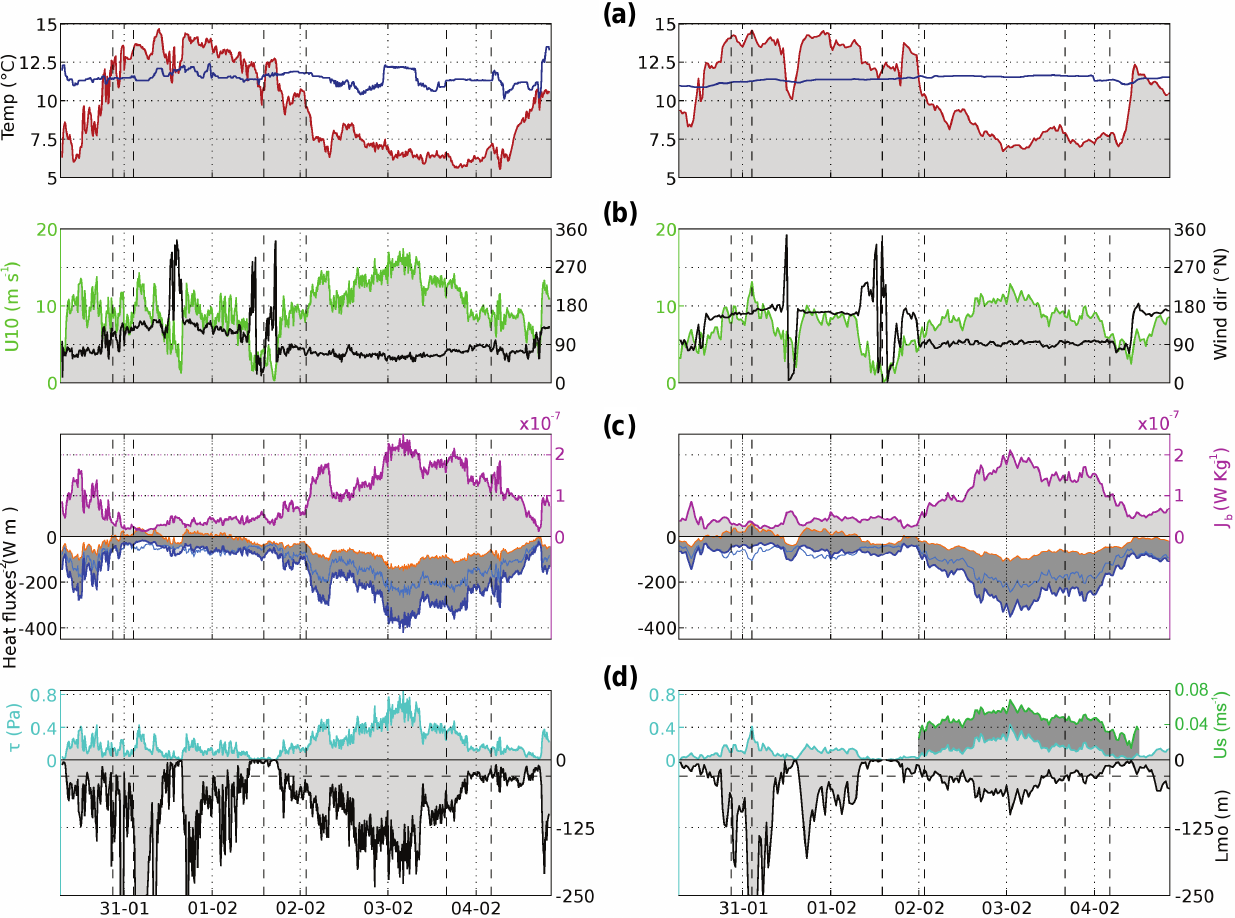
Figure 2. Atmospheric and sea-surface observations and fluxes collected from the R/V Urania (left panels) and VIDA buoy (right panels). (a) Air (red) and sea (blue) temperature time series; (b) wind speed (light green) and wind direction (black); (c) net (blue line), latent (light blue) and sensible (orange) heat fluxes computed with the COARE algorithm and buoyancy flux (magenta); (d) wind stress (cyano), Monin– Obukhov length (black) and Stokes drift (dark green). Given that the maximum depth of the GoT is 25m, L mo is shown up to − 250m depth to provide a clearer representation of the water column. L mo values can be as low as − 1200m during calm periods. Vertical dashed lines show the yoyo cast collection